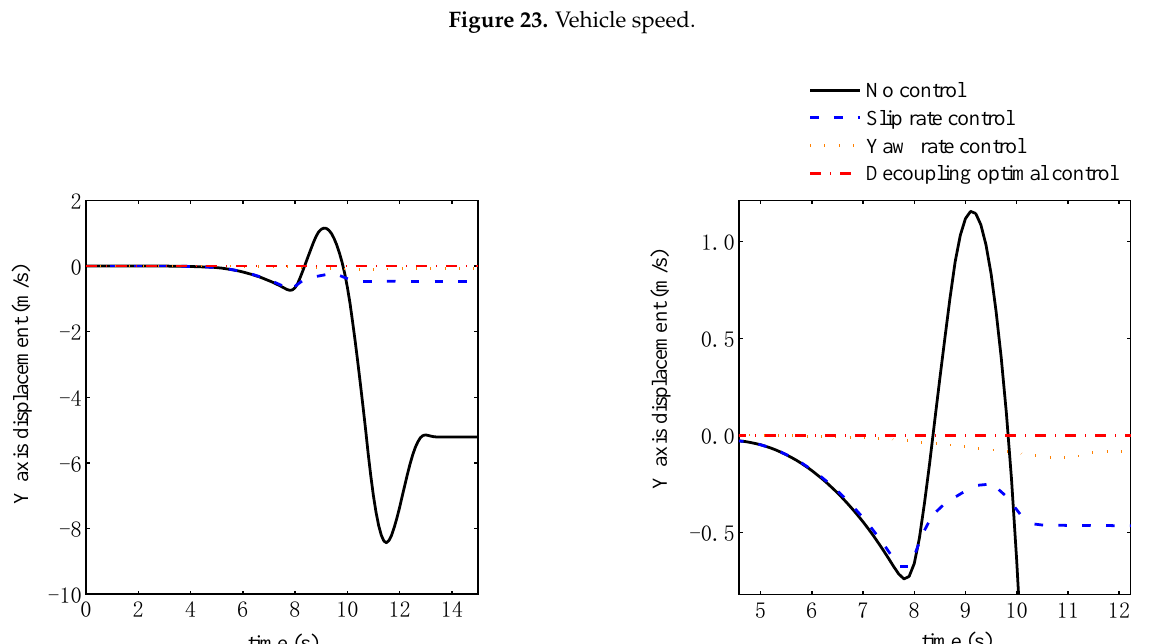
Figure 23. Vehicle speed.